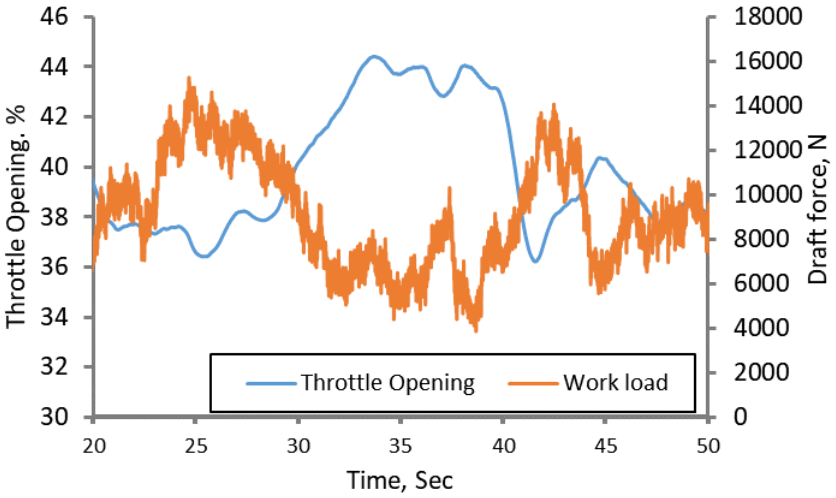
Figure 5. Throttle opening and workload data for the simulation model.